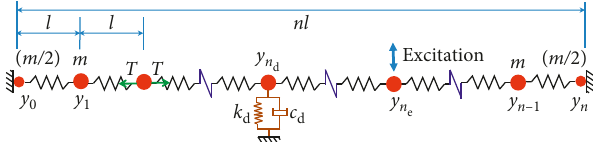
Figure 1: Discrete model of a stay cable with a passive NSD at- tached in the transverse